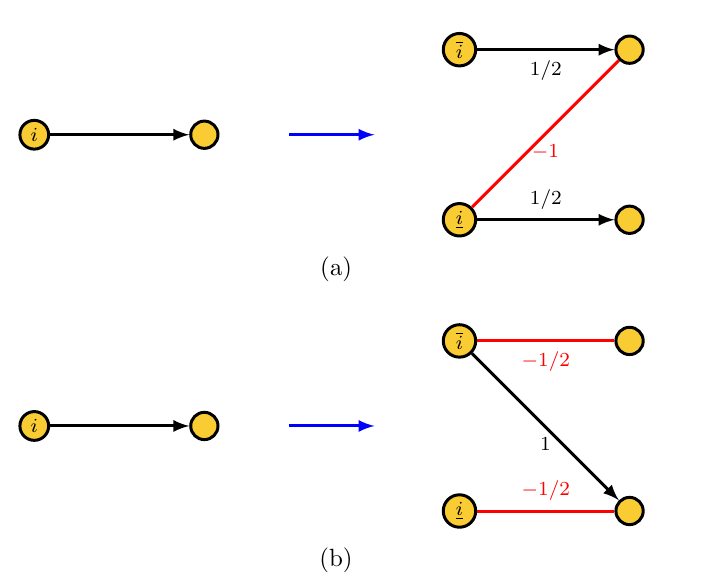
Figure 5. 2 d descendants of an outgoing 4 d chiral (cid:12)eld at node i that: a) is not in p and b) is in